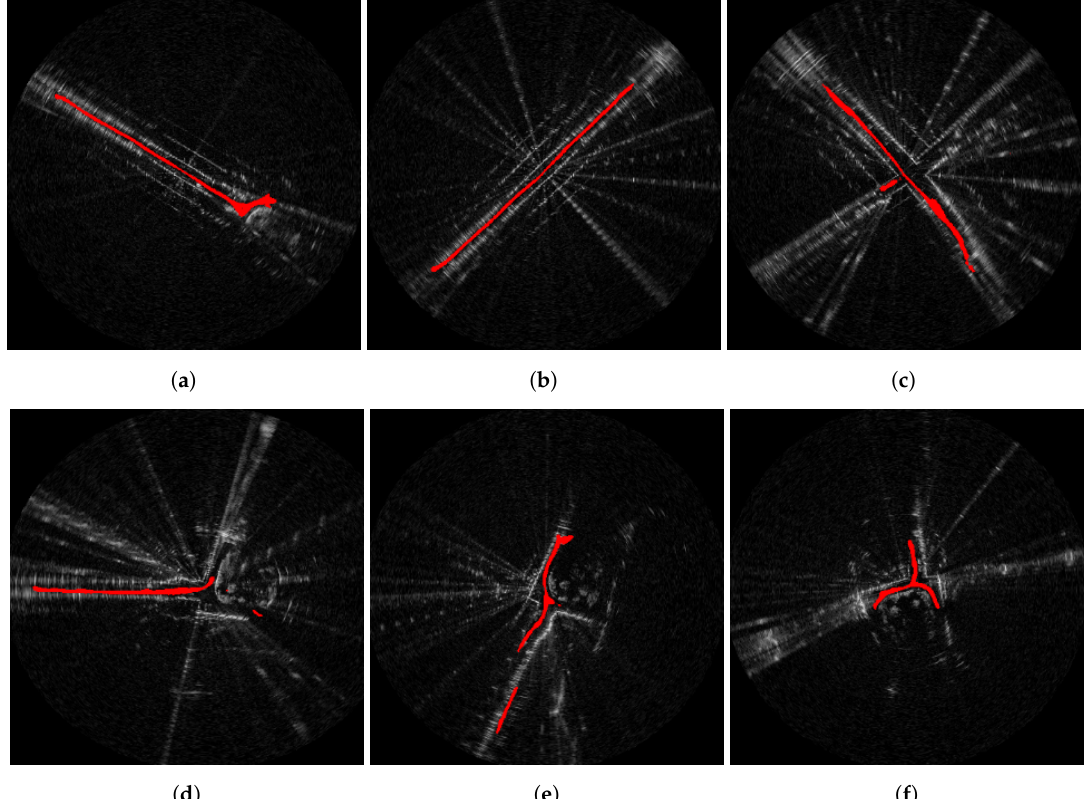
Figure 17. A sample of route proposal cases for straight road segments (top row) and junctions (bottom row). The model deployed here was trained only using route labels (c.f. L 2 in the learned objectives of Section 4.2.2). In ( a ), the vehicle track width of 1.4m is not totally maintained by